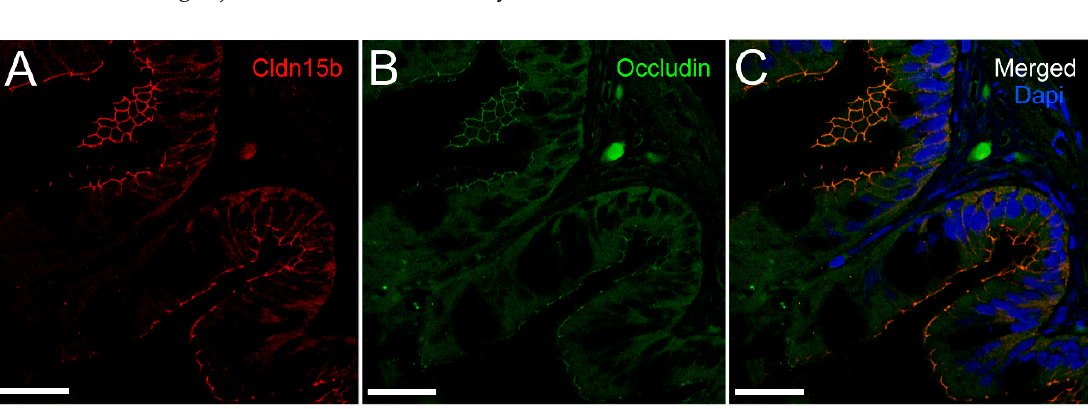
Figure 10. Confocal images showing Cldn15b ( A , red), occludin ( B , green) and co-localization ( C , merged) in SW-acclimated medaka middle intestine. In ( C ), nuclei are stained blue with DAPI. Size bars indicate 20 μ m.